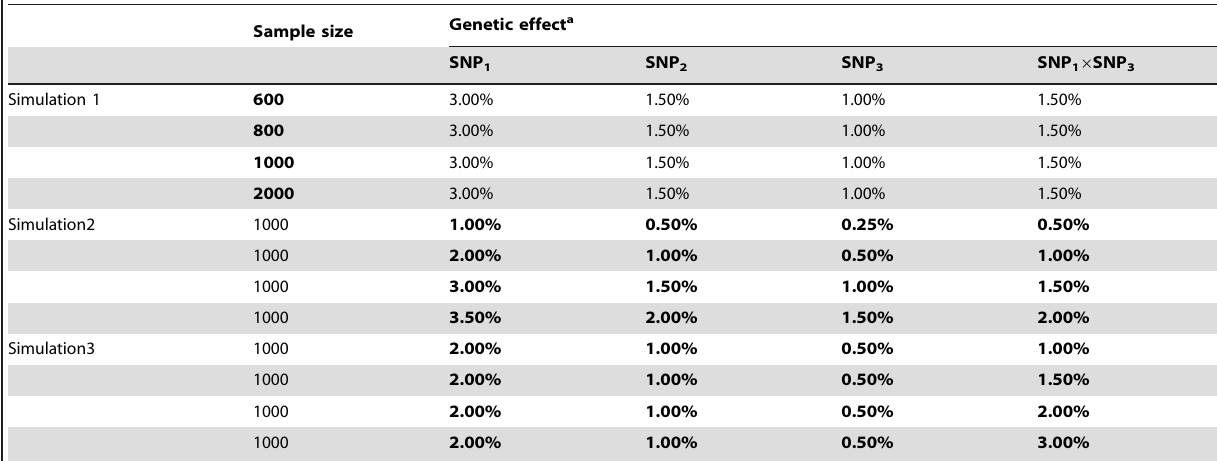
Table 1. Parameter configurations in the simulation